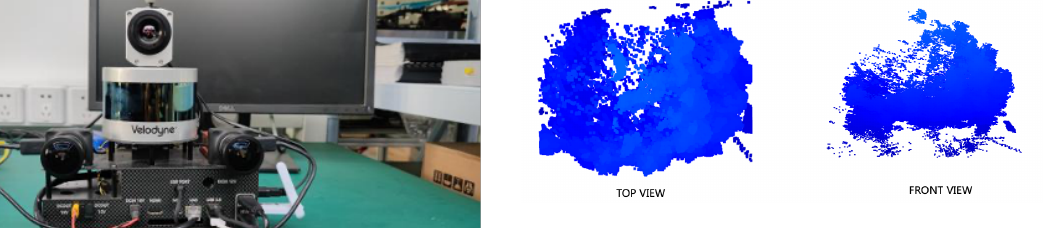
Figure 13. Correct Split Results. The Segmented tree without messy ground plane is more